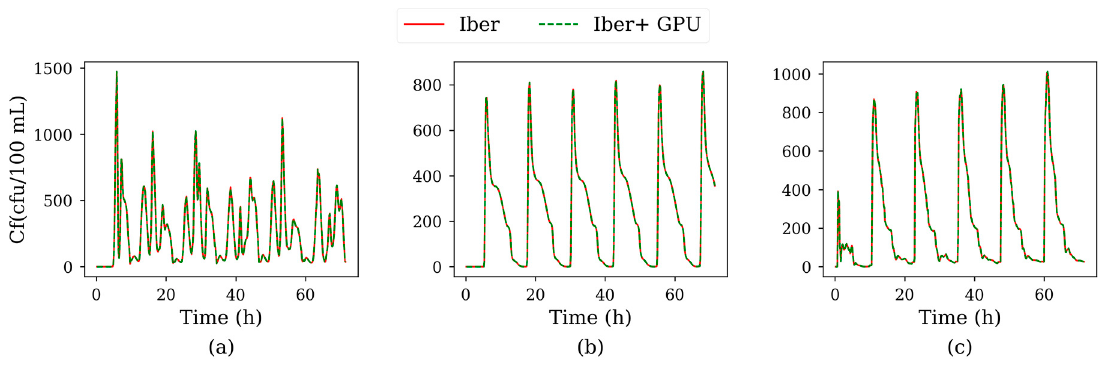
Figure 5. Time series of E. coli concentration at control points P1 ( a ), P2 ( b ) and P3 ( c ), for the first test case.